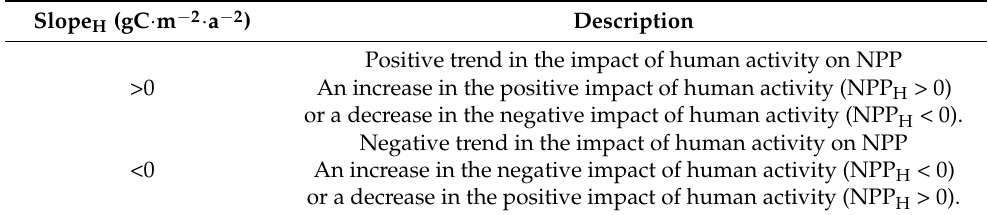
Table 1. Trend in the impact of human activity.